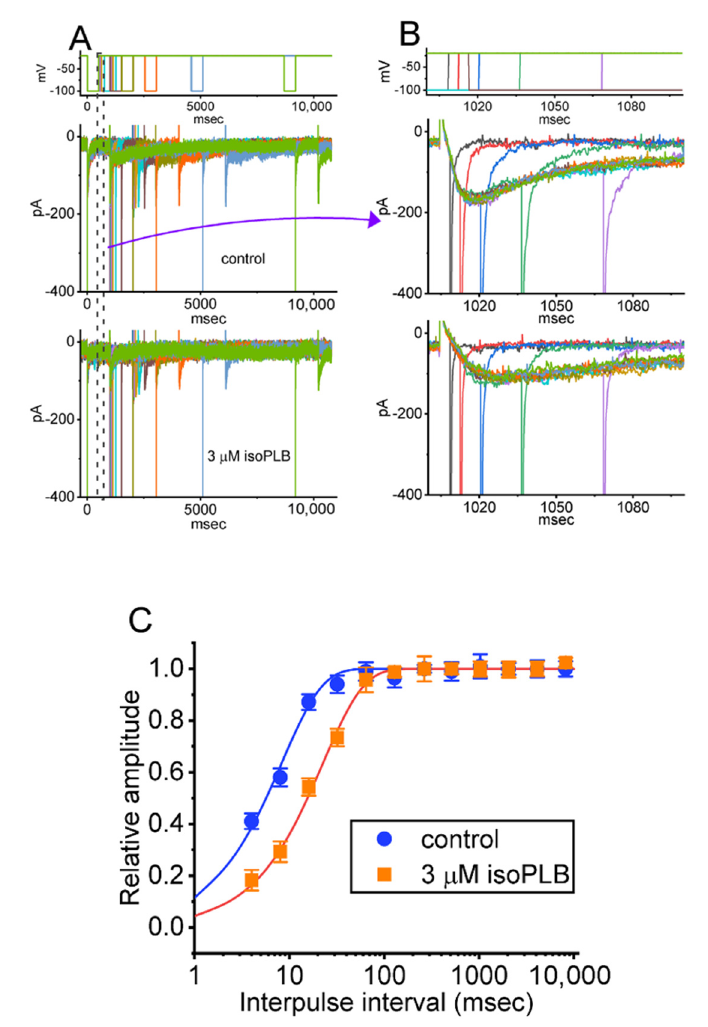
Figure 4. Modification by isoPLB of the recovery of the I K(erg) block seen in GH 3 cells. These meas- urements were undertaken in cells bathed in a high-K + , Ca 2+ -free solution, and the recording elec- trode was filled with a K + -containing solution. As the whole-cell configuration was firmly estab- lished, we imposed a two-step voltage protocol with a geometric progression onto the examined cells. ( A ) Superimposed current traces attained in the control period (i.e., absence of isoPLB) and during cell exposure to 3 μ M isoPLB. The uppermost part in ( A , B ) shows the pulse protocol applied. In ( B ), the potential and current traces are the expanded records from the dashed box in ( A ). ( C ) Relationship of the interpulse interval versus the relative amplitude obtained in the absence (solid blue circles) and presence (solid orange squares) of 3 μ M isoPLB (mean ± SEM; n = 8 for each point). The relative amplitude achieved in the ordinate was taken when the second amplitude evoked by a 1-sec hyperpolarizing voltage-clamp command from − 10 to − 100 mV was divided by the first. The smooth curve without and with cell exposure to 3 μ M isoPLB was least-squares fitted to a single exponential with time constants of 8.2 and 22.4 msec, respectively. The y axis is illustrated with a logarithmic scale. Of notice, the presence of isoPLB can lead to a prolongation of recovery from the I K(erg) block evoked by such a two-step voltage command